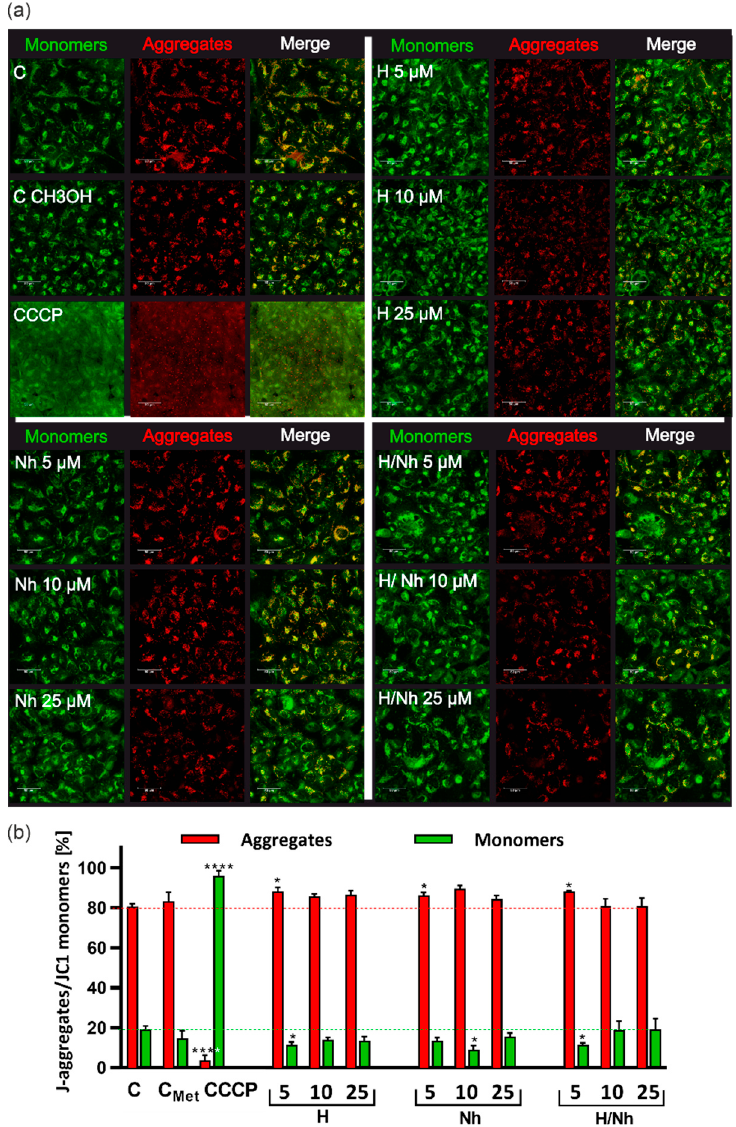
Figure 3. Mitochondrial oxidative stress analysis after harmane and norharmane treatment. ( a ) Confocal microscopy analysis of the mitochondrial membrane status in MRC-5 after 24 h of harmane (H), norharmane (NH), and mix of both (H / NH) treatment (5, 10, and 25 µ M) determined by JC-1 staining. Left panels show JC-1 monomers (green fluorescence, Ex / Em 485 / 530 nm) which indicate a decrease of mitochondrial potential and the middle panels present the J-aggregates (red fluorescence, Ex / Em 535 / 590 nm) which indicate high membrane potential. Merged images are on the right panels. ( b ) Flow cytometry analysis of changes in the mitochondrial membrane potential ( Ψ m). The fluorescence intensity histograms are representative of three independent experiments, whereas the bar graphs represent the mean fluorescence intensity ± SEM. Statistical significance (ANOVA): (*) p < 0.05, (**) p < 0.01, (***) p < 0.001, (****) p < 0.0001. CCCP (50 µM) was used as a positive control to decrease Ψ m.